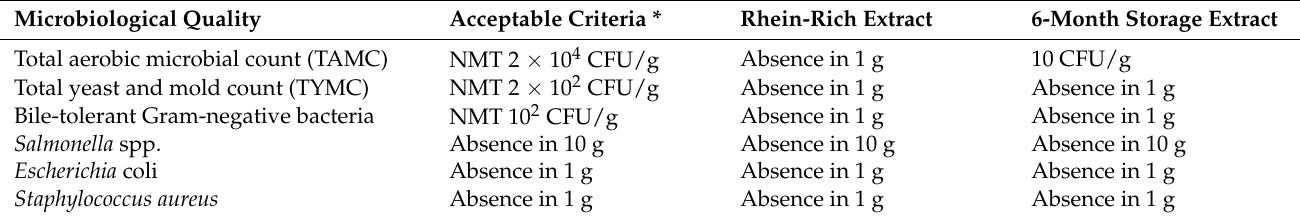
Table 13. Microbiological quality of the rhein-rich extract and its 6-month storage at 4 ◦ C. Microbiological